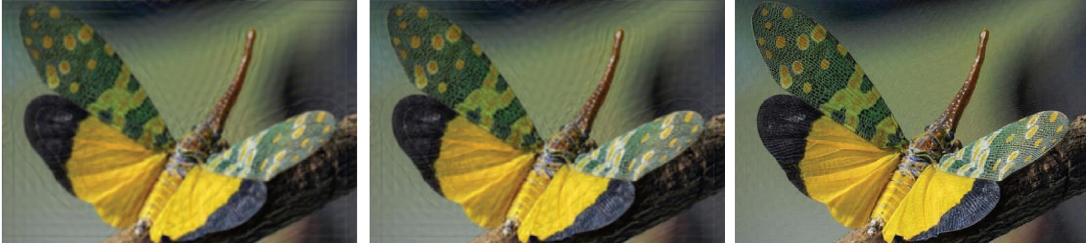
th , 1 , 000 th , and 20 , 000 th used iterations. G being 50